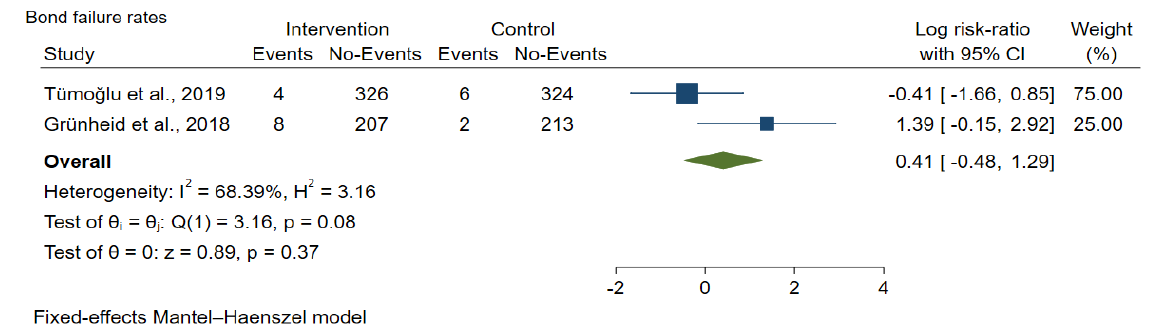
Fig. 2. Forest plot showed the bond failure rate risk ratio between the flash-free and control groups.